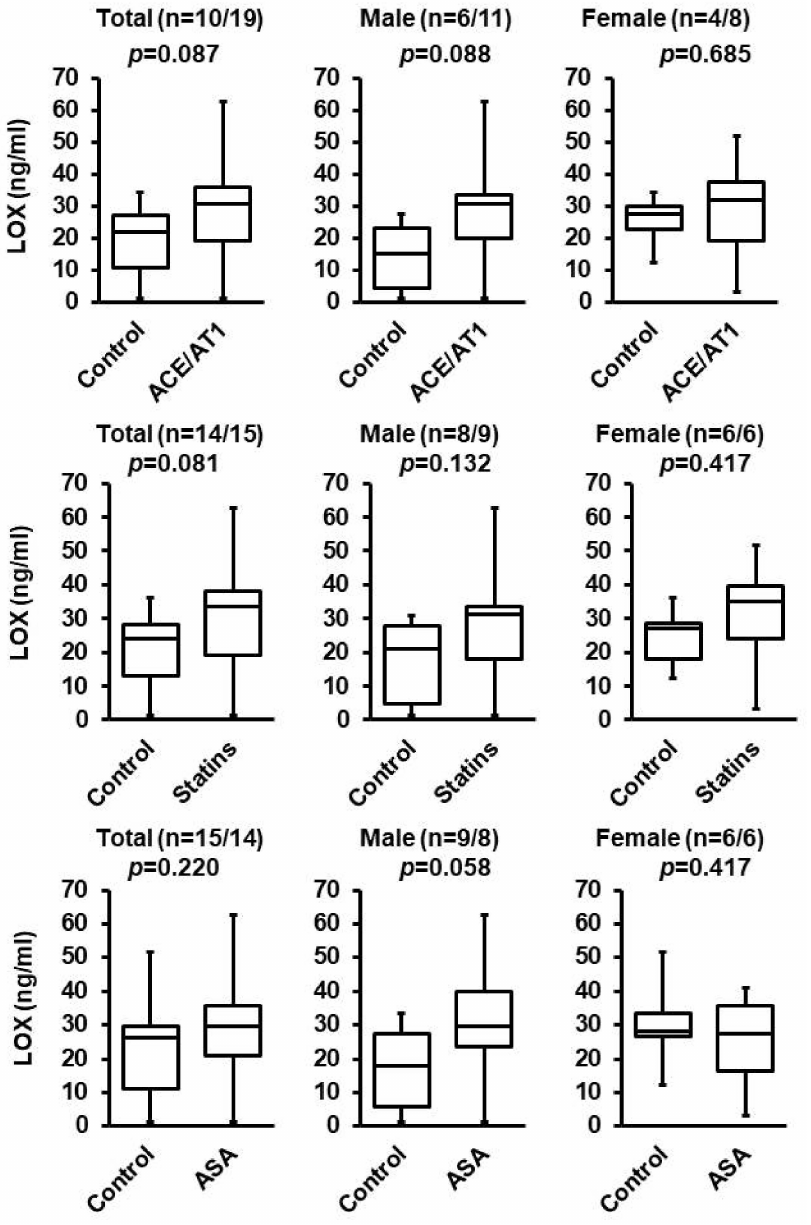
Figure 1. Effect of ACE/AT1 antagonism, statins, or ASA on plasma concentrations of LOX in hypertensive patients. LOX plasma concentrations in patients from cohort 1 (hypertension) either without (control) or with specified treatment (ACE/AT1 antagonism, statins, or ASA). Data are shown separately for the whole cohort, men only, and women only. The box and whiskers plots show the total range (whiskers), Q25, Q50, and Q75. Exact p -values are given and n-values are